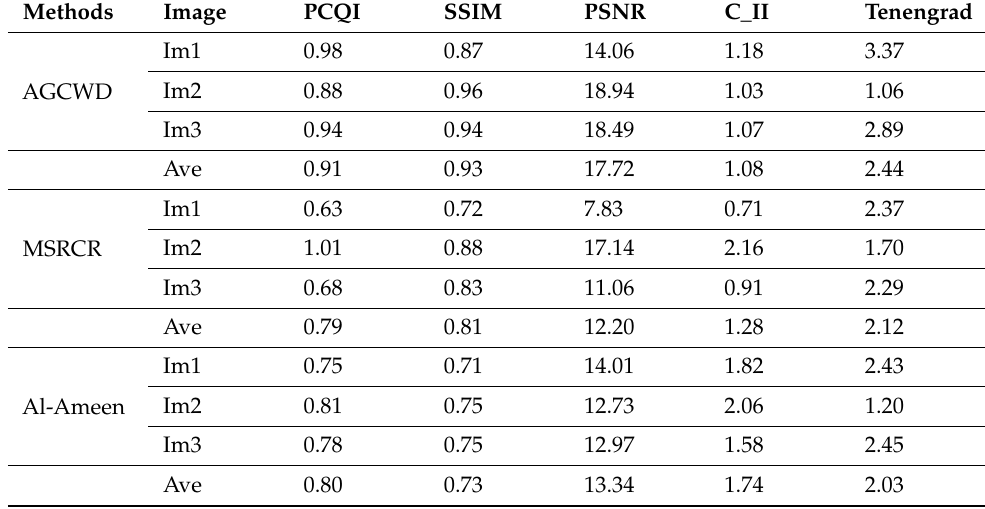
Table 1. Comparison chart of five evaluation indexes.